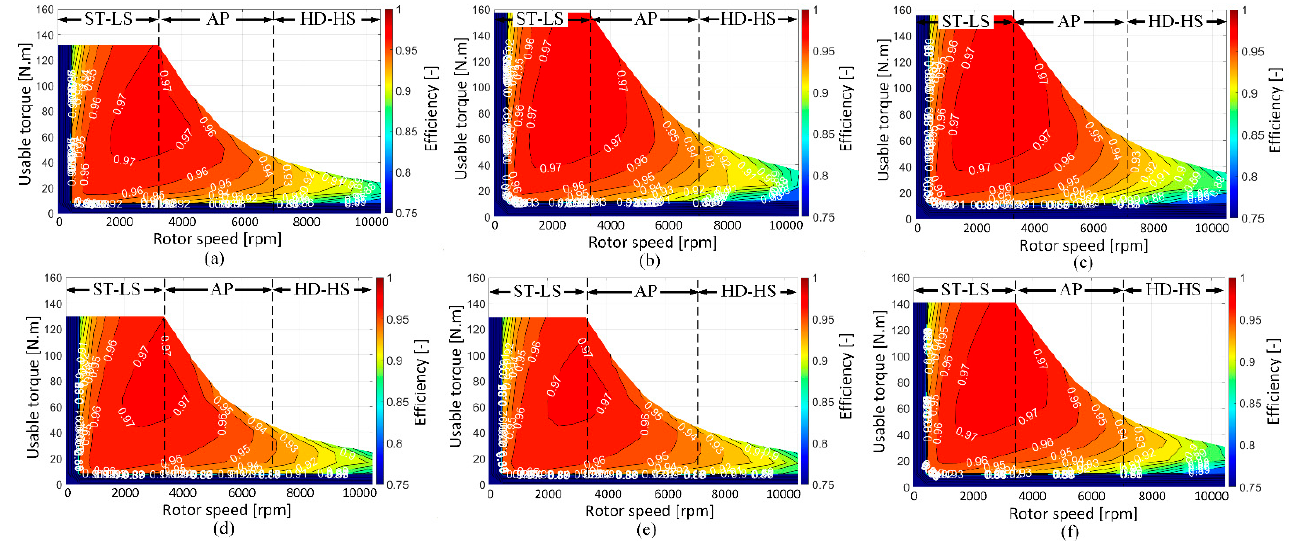
Figure 7. Power efficiency maps for the IPMSM with ( a ) R-ROW, ( b ) R-SOW, ( c ) R-IOW, ( d ) RCL-SOW, ( e ) RCL-IOW, and ( f ) H-NOW arrangements.